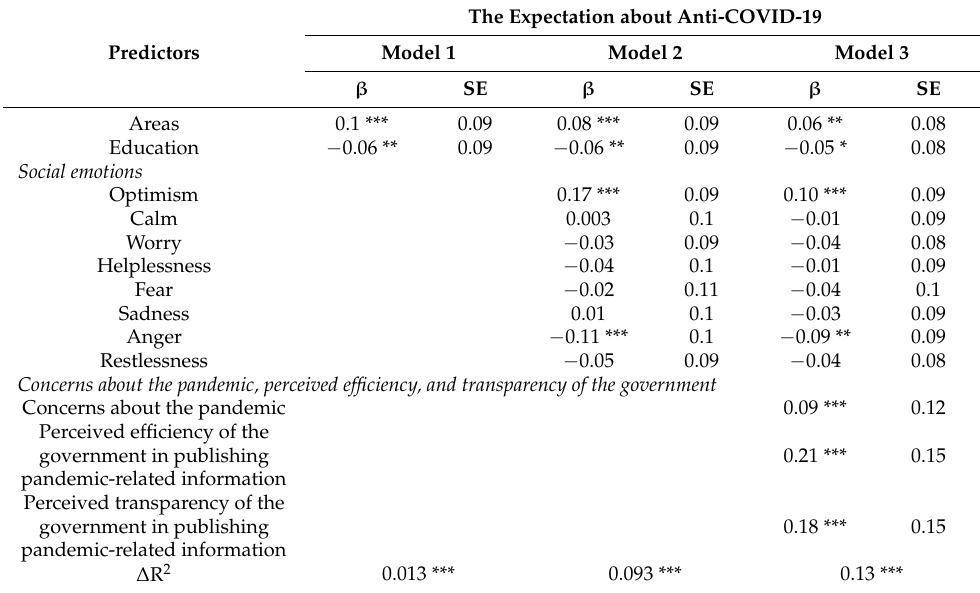
Table 4. Predicating the expectation about anti-COVID-19 in Hierarchical Regression